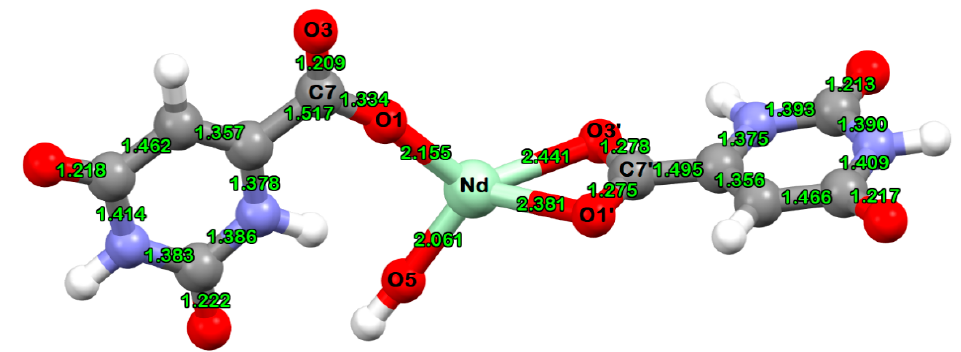
Figure 4. B3LYP/cc-pVDZ(SDD)-optimized molecular structure of the Nd(III) complex of orotic Figure 4. B3LYP/cc ‐ pVDZ(SDD) ‐ optimized molecular structure of the Nd(III) complex of orotic acid.